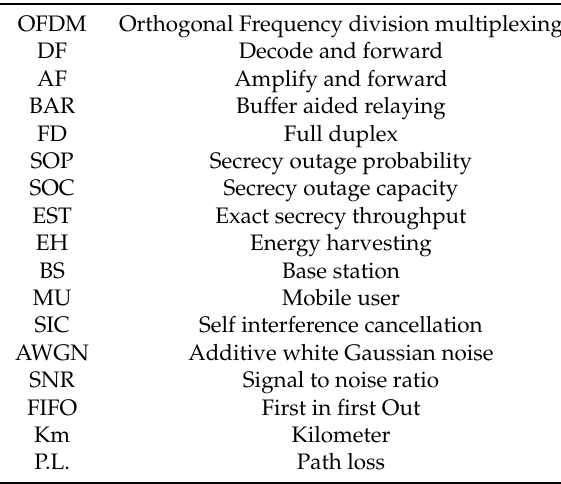
Table 1. List of